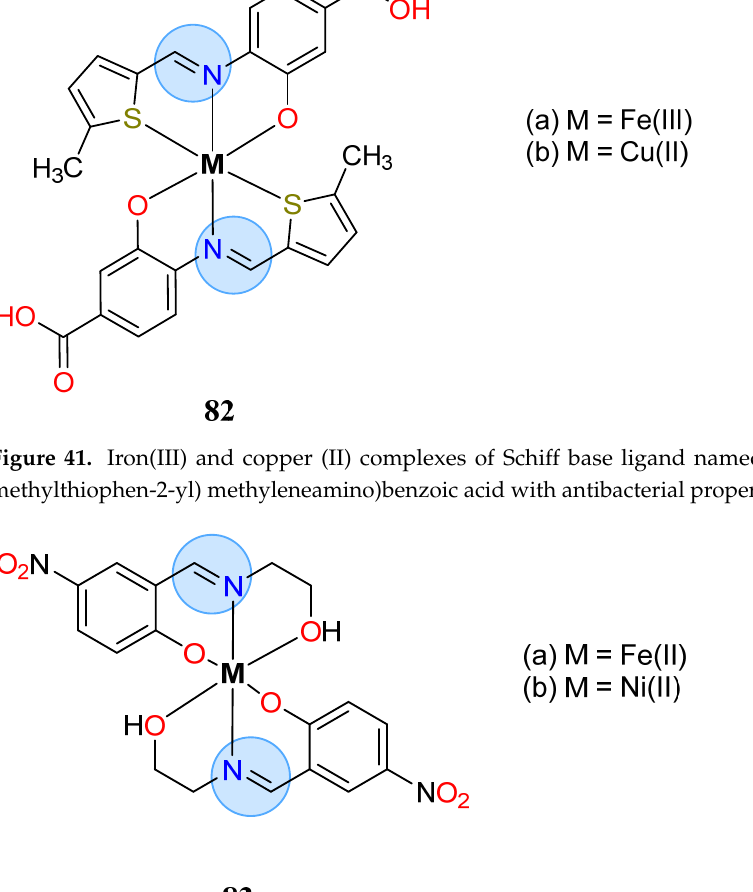
Figure 42. Fe(II) and Ni(II) complexes with